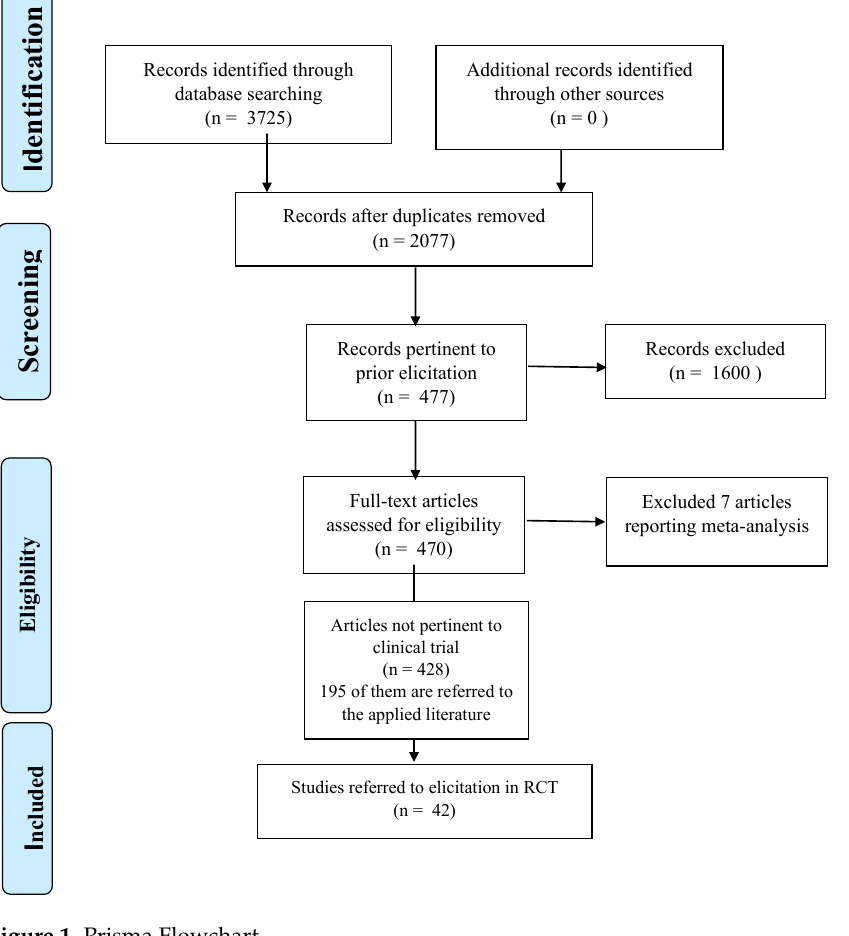
Figure 1. Prisma Flowchart.